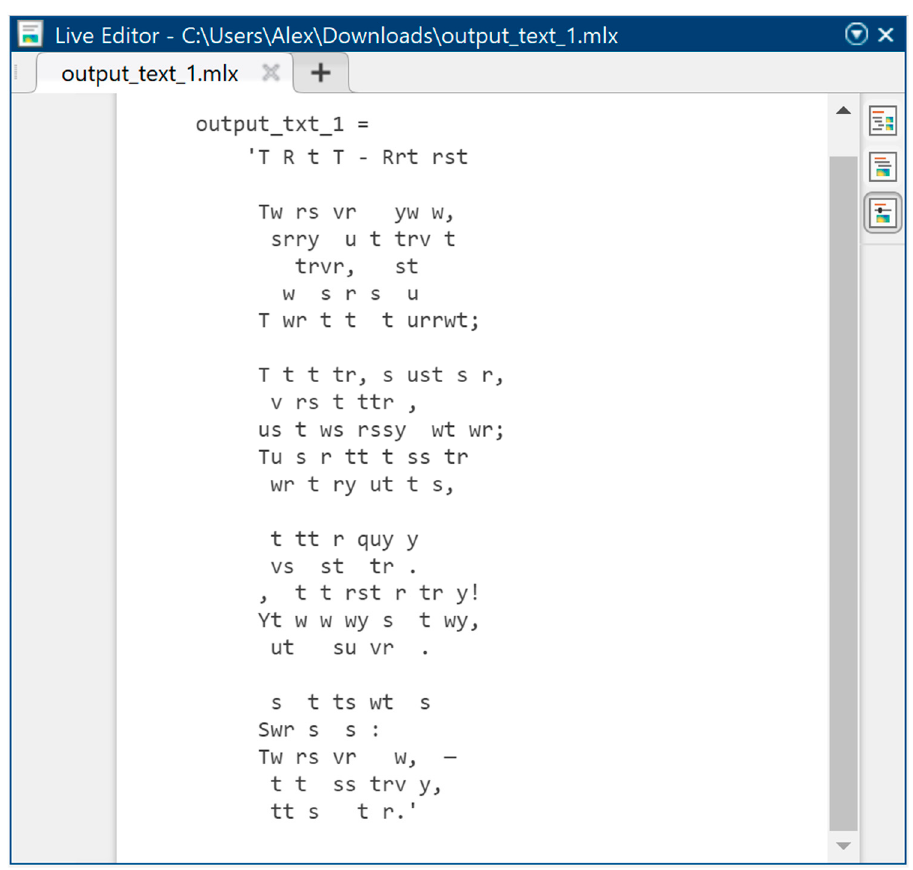
19 of 29 Figure 9. Wavelet coefficients of compressed steganocoded audio signal by 30 times (existing method).